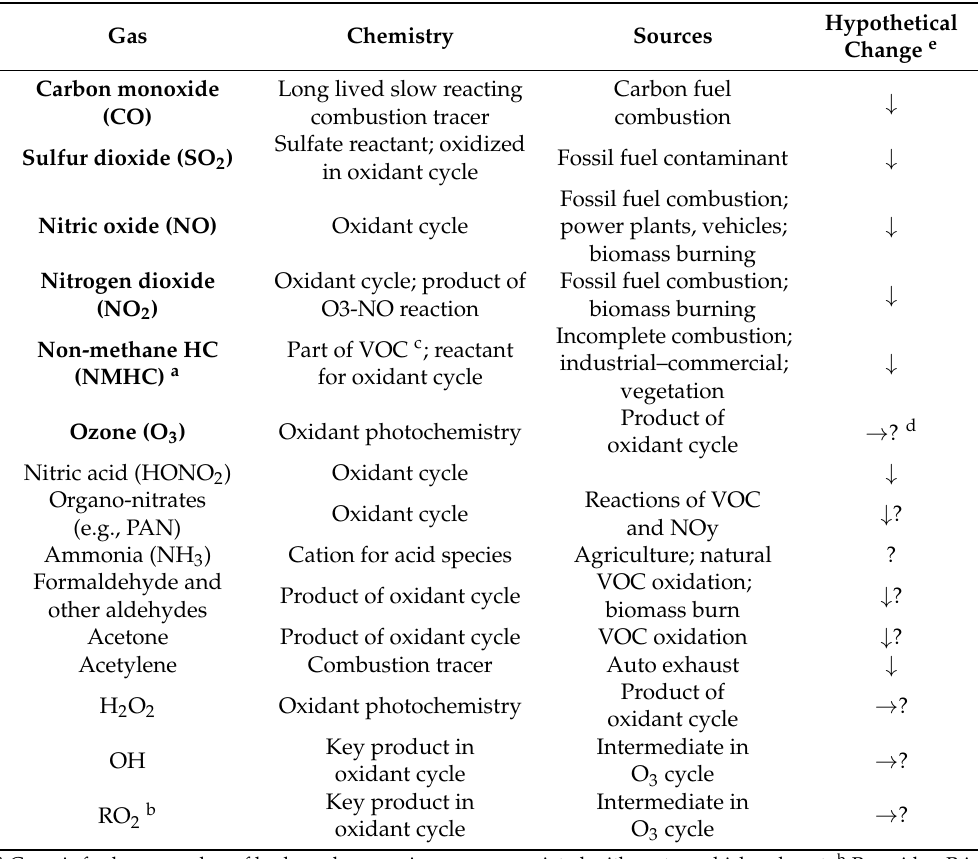
Table 1. Examples of gas phase components as key indicators of the chemical processes associated with urban pollution and background chemistry. Species in bold are routinely monitored.